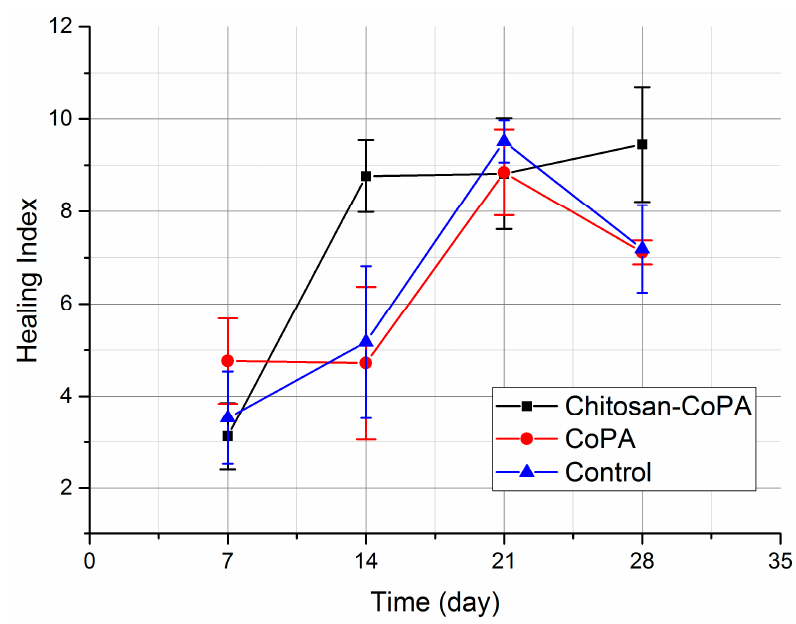
Figure6. Comparison of healing indices for experimental and control groups. Figure 6. Comparison of healing indices for experimental and control groups.